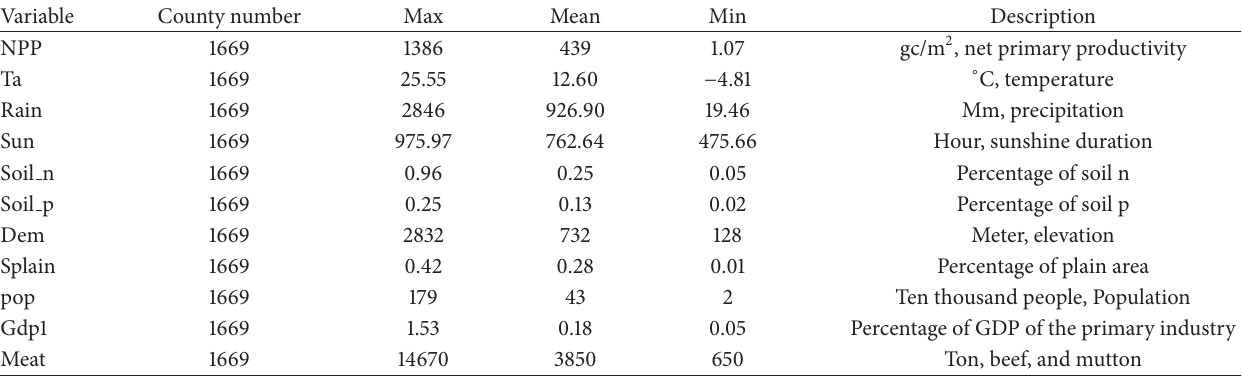
Table 1: Summary of the variables used in this